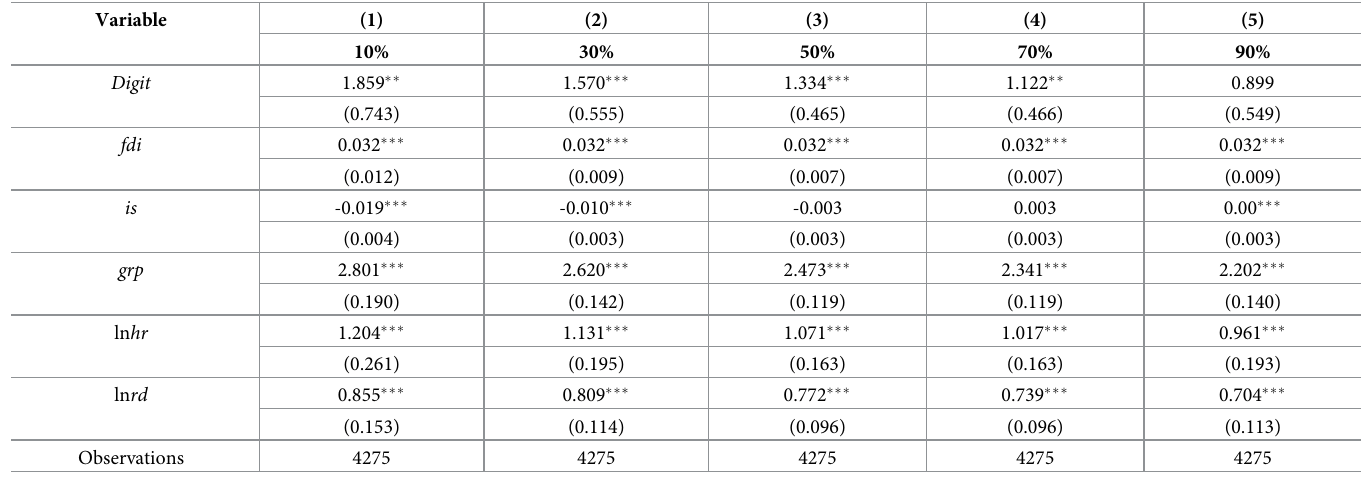
Table 5. Results of quantile